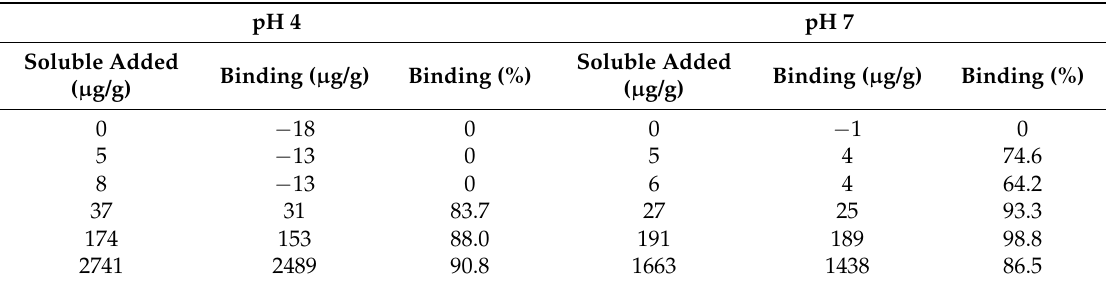
Table 5. Fe binding to biochar at pH 4 and pH 7.